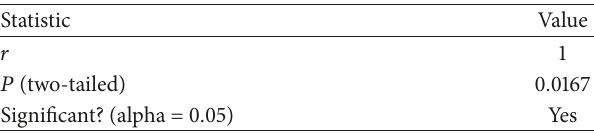
Table 2: Results of the Spearman correlation test.